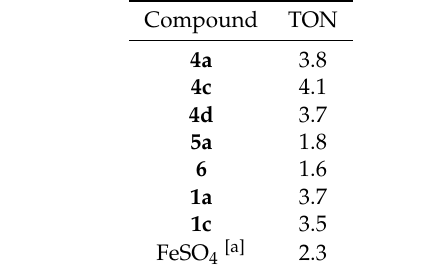
Table 4. Turnover numbers (TON) of iron compounds (10 µ M) in the aerobic oxidation of NADH (220 µ M) in a 5% DMSO phosphate bu ff ered solution at 37 ◦ C after 25 h. FeSO 4 used as a reference